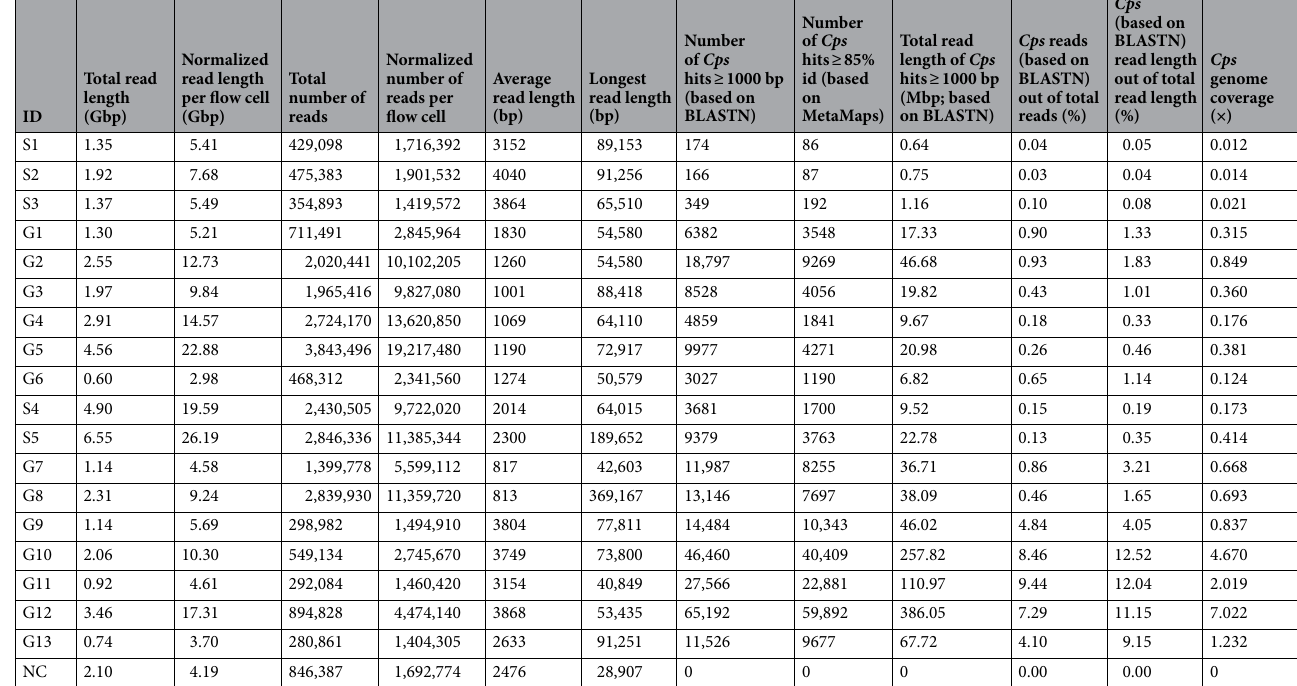
Table 2. Summary of ONT MinION sequencing data obtained in this study (see Table 1 for sample metadata). Gbp giga base pairs, Mbp mega base